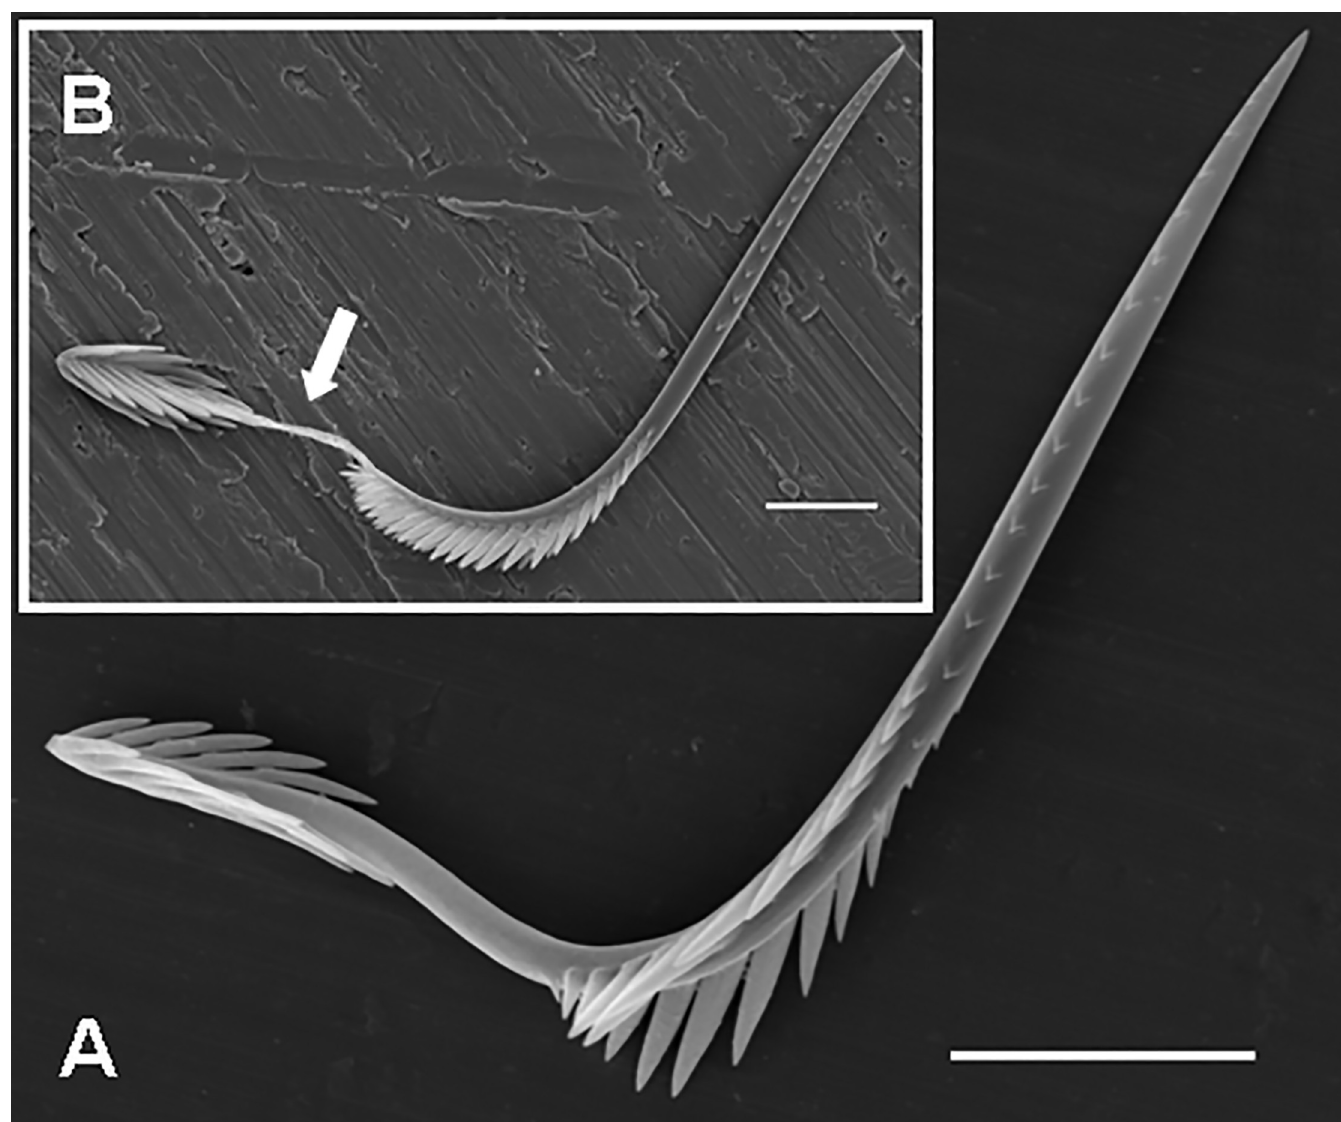
Fig 6. Urticating setae of type I and its subtypes I e and I f . (A) Metriopelma sp., female from Margarita Island, Venezuela. Type I, subtype I e , midsection C1 with barbs reduced both in length and number, midsection C2 completely bare, smooth and thicker than in the subtype I f . (B) Pseudhapalopus sp., male from Colombia. Type I, subtype I f , with the midsection C2 narrow and flattened, with a rough surface. Section C2 represents a zone in which the seta breaks off. Scale bar = 20 μ m.